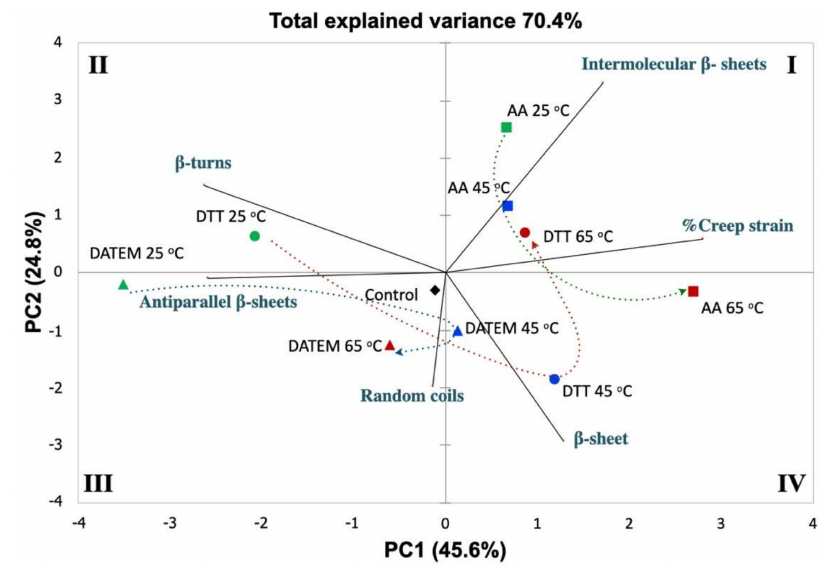
Figure 5. Principal component analysis of gluten with six indicators of secondary structural motifs and the viscoelastic property (creep strain) showing the effect of temperature (25, 45, and 65 ◦ C) and additive (AA, DATEM, and DTT) treatments. Treatments: 25 ◦ C, green; 45 ◦ C, blue; 65 ◦ C, red; AA, square; DATEM, triangle; and DTT, circle. I-IV are graph quadrants in the Cartesian